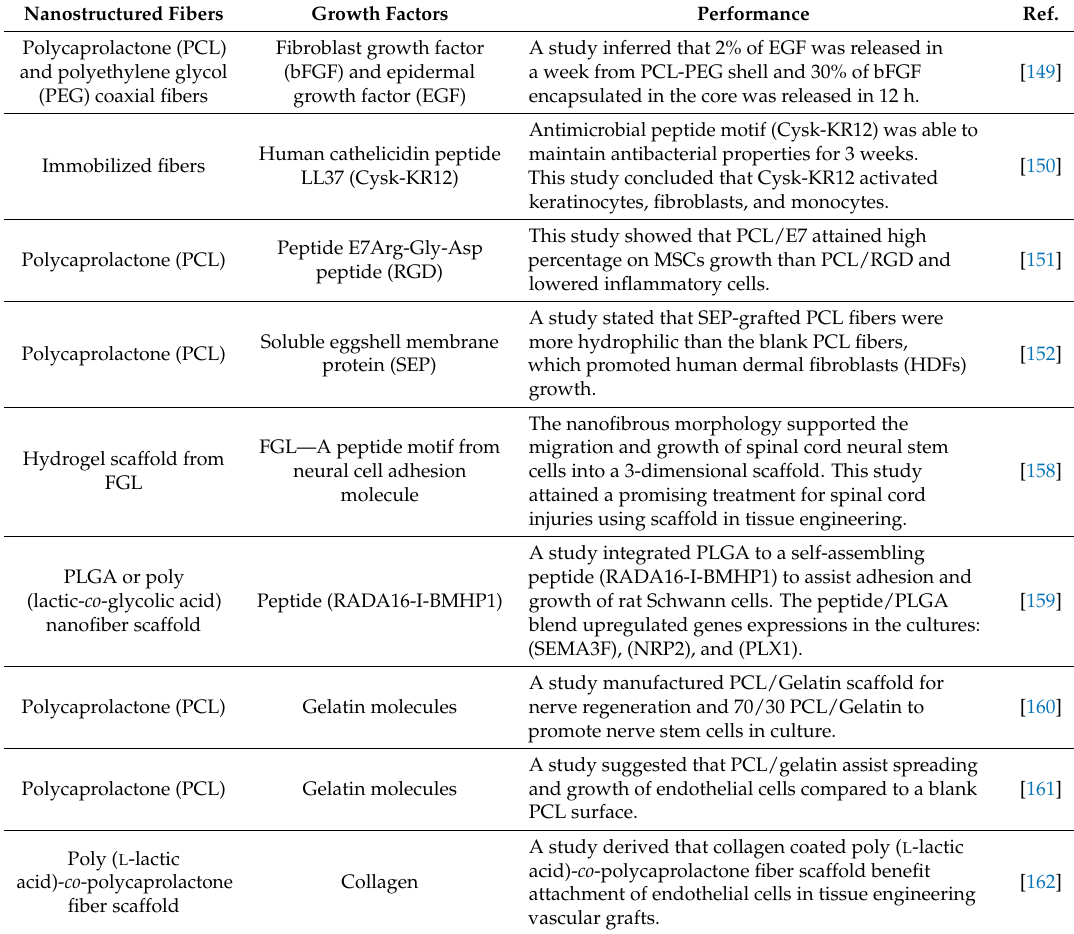
Table 3. Nanostructured fibers for tissue engineering